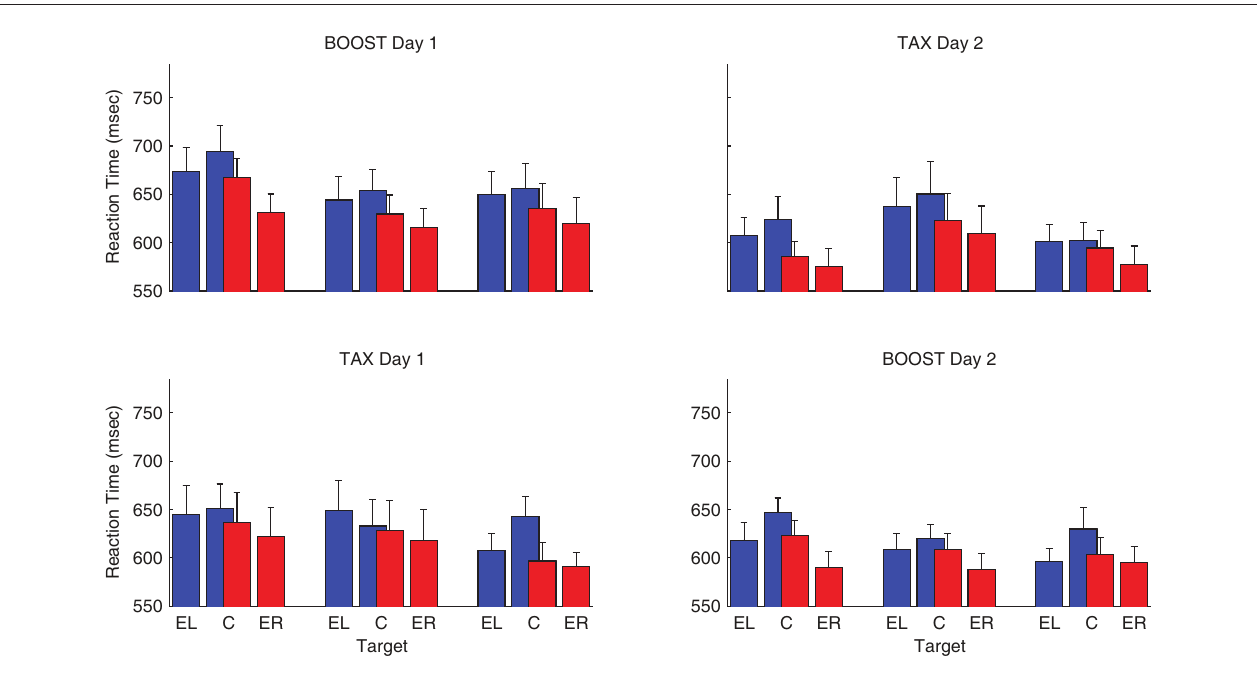
Figure 7 | Left (blue) and right (red) hand reaction time data for experiment 2. The data are plotted for the three phases (baseline: left cluster; manipulation: center cluster; post-manipulation: right cluster). Within each